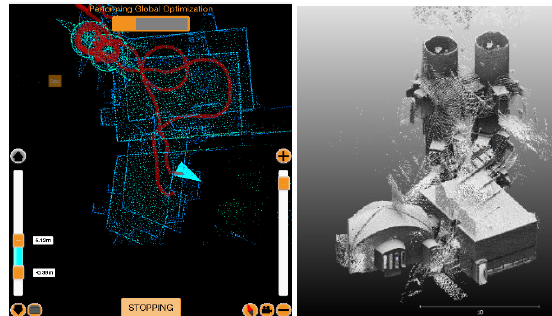
Figure 6. SLAM-base registration errors. (left) The real-time result in a multi-level scan inside the tower. (right) The result of the merge processing with another scan.